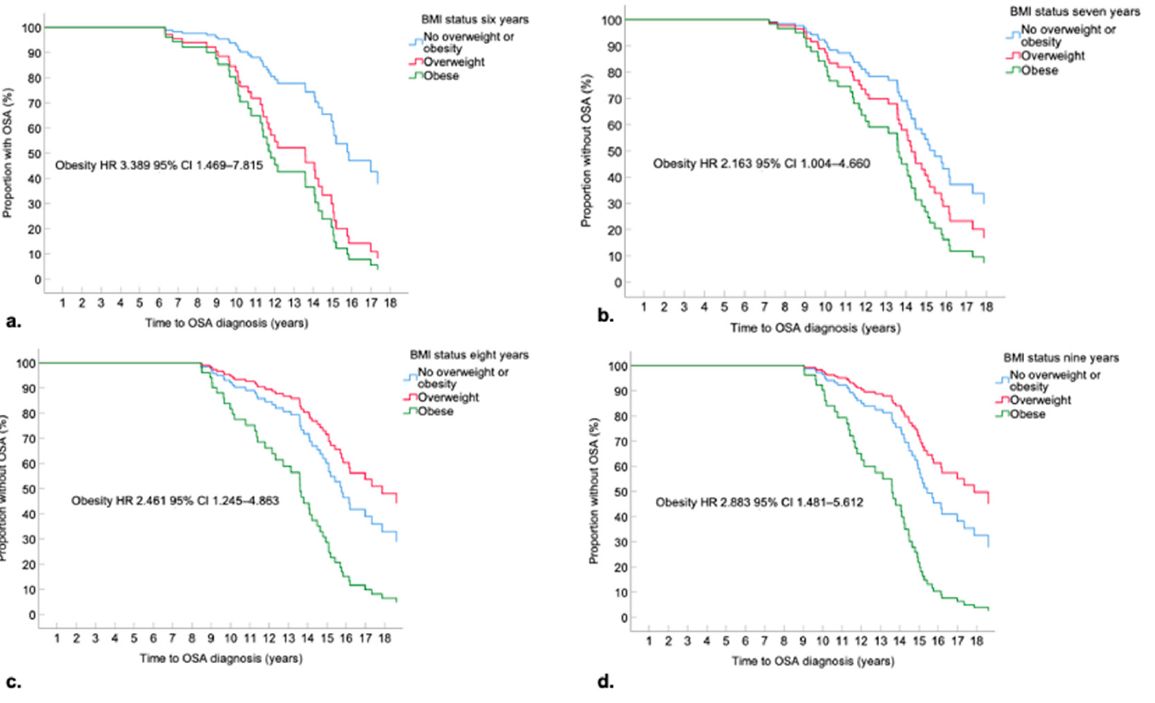
Figure 4. Kaplan-Meier Curve Time to OSA Diagnosis Stratified by BMI Status at Ages ( a ) Six Years ( b ) Seven Years ( c ) Eight Years ( d ) Nine Years.